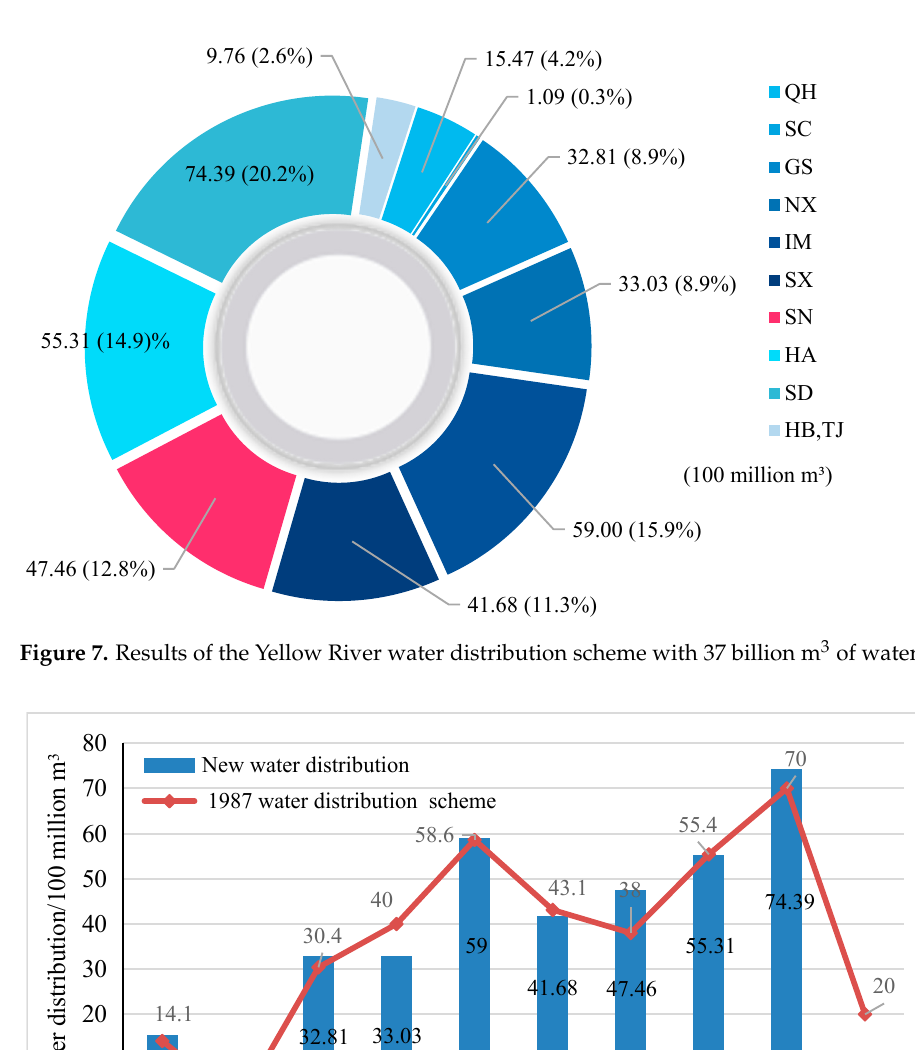
Figure 6. ( a ) Water distributions of the six water distribution schemes. ( b ) The weights of the six water distribution schemes.